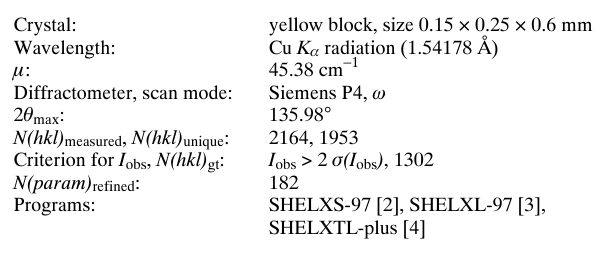
Table 1. D a t a collection a nd h a ndling.